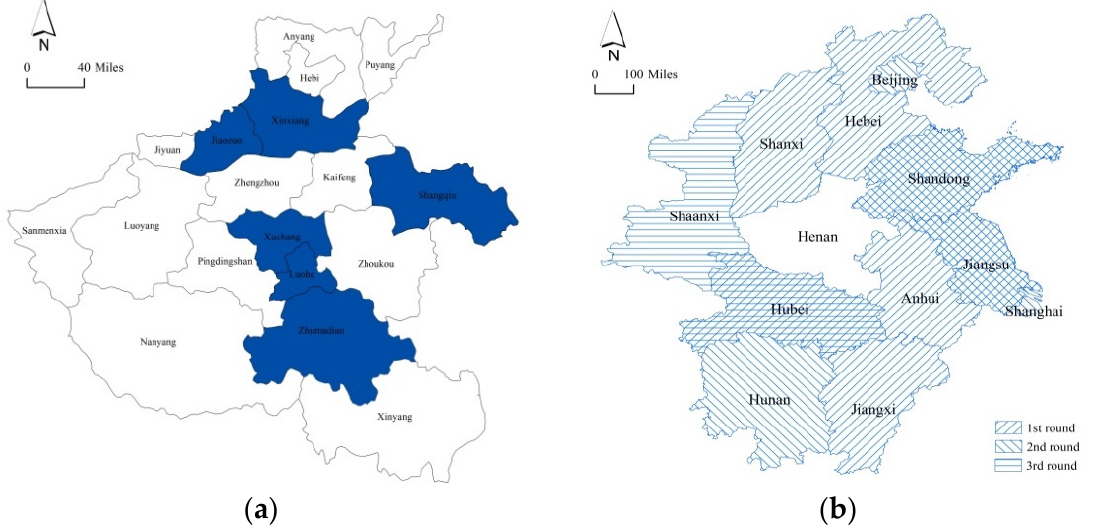
Figure 2. The location of reinforcement provinces/cities: ( a ) reinforcement from six cities in Henan province; ( b ) three rounds of reinforcements from other provinces/cities.